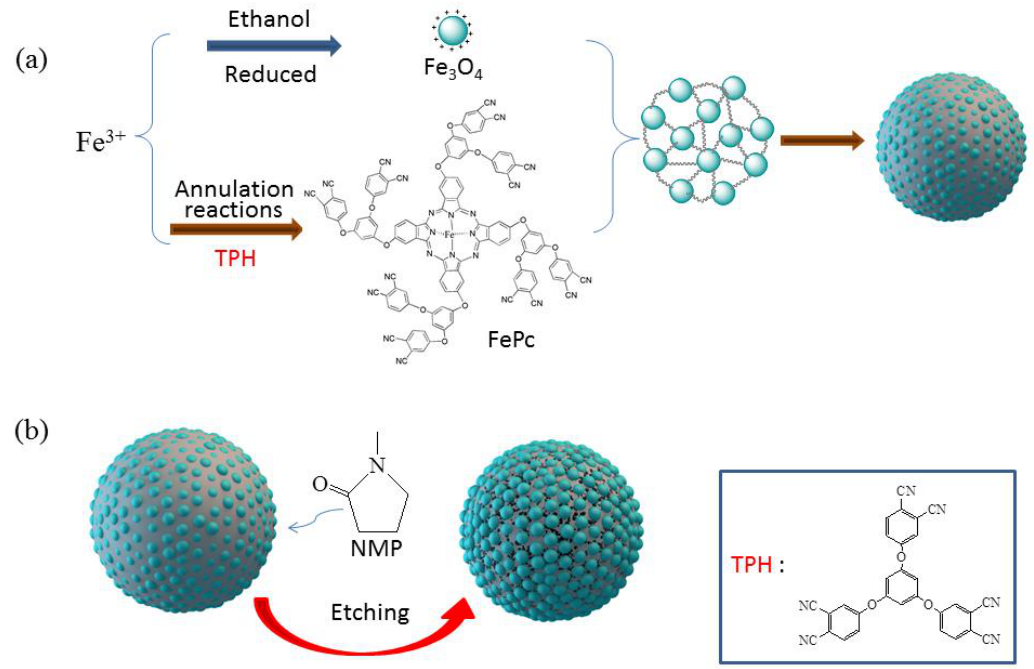
Scheme 1. The schematic illustration of the preparation of ( a ) the original Fe 3 O 4 /FePc hybrid microspheres and ( b ) the etched Fe 3 O 4 /FePc hybrid microspheres.